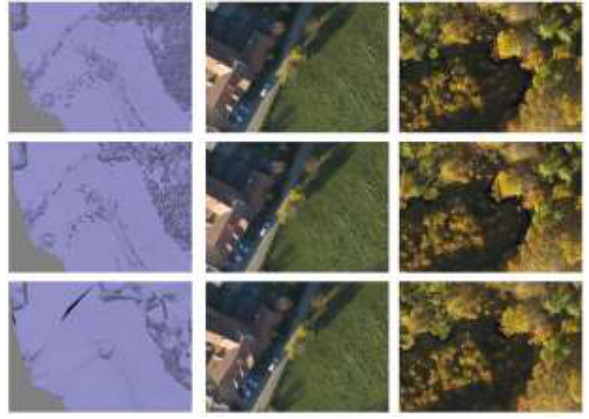
Figure 7. Example of mosaicking result with different set of mesh parameters for surface